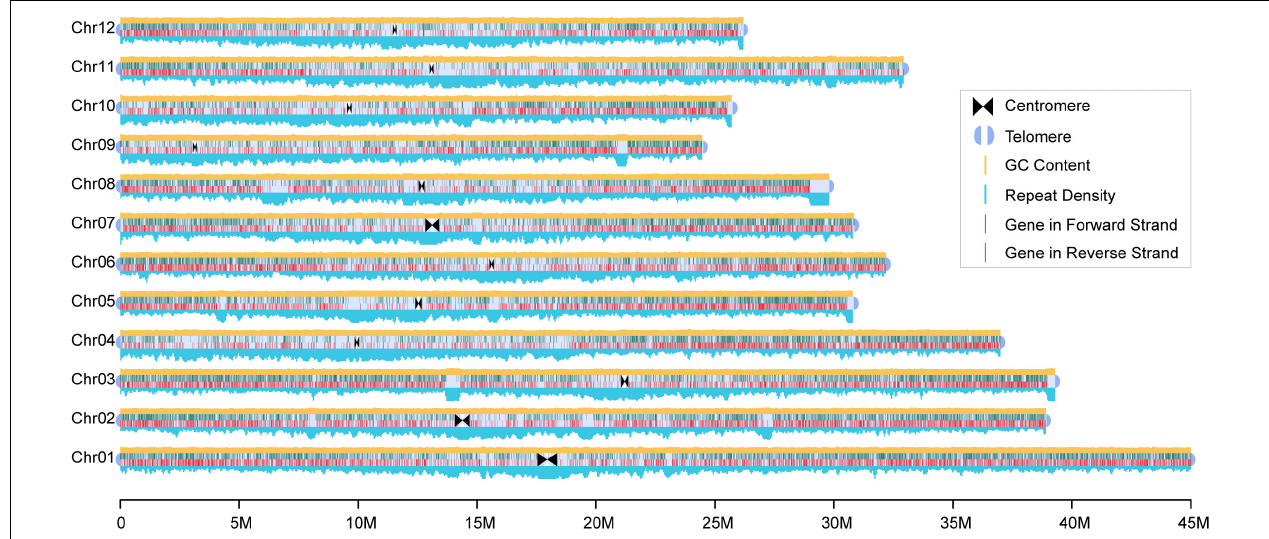
FIGURE 1 | Reference genome of the 93-11. The high-quality chromosome level reference genome of the rice cultivar 93-11 was constructed. The triangle and semicircle represent the centromere and telomere, respectively. Distribution of repetitive sequences and GC content are drawn on the top and bottom of the chromosome with a window size of 100 Kb, respectively. Lines within the chromosomes represent genes, and dark green and red mean locating in the positive and negative strands,